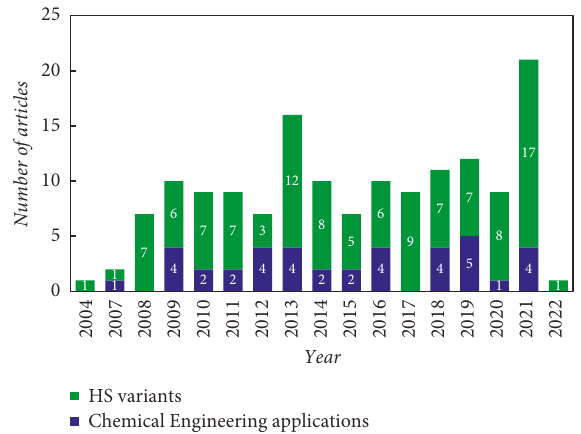
Figure 5: Number of articles published per year on harmony search variants and their applications in chemical engineering